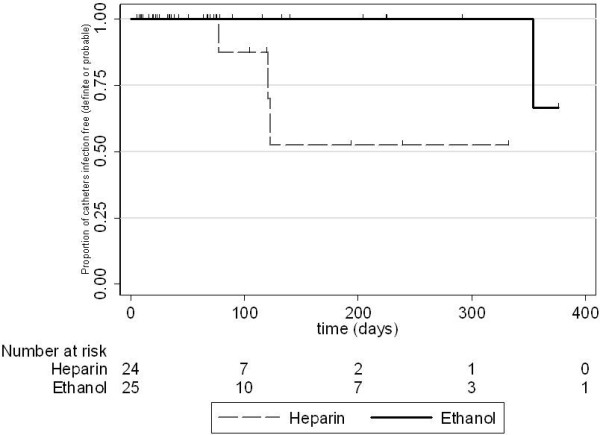
Kaplan-Meier infection-free survival curves for the heparin and ethanol groups. Censoring events are indicated in the graph. The numbers at risk at each time point are shown below the abscissa.